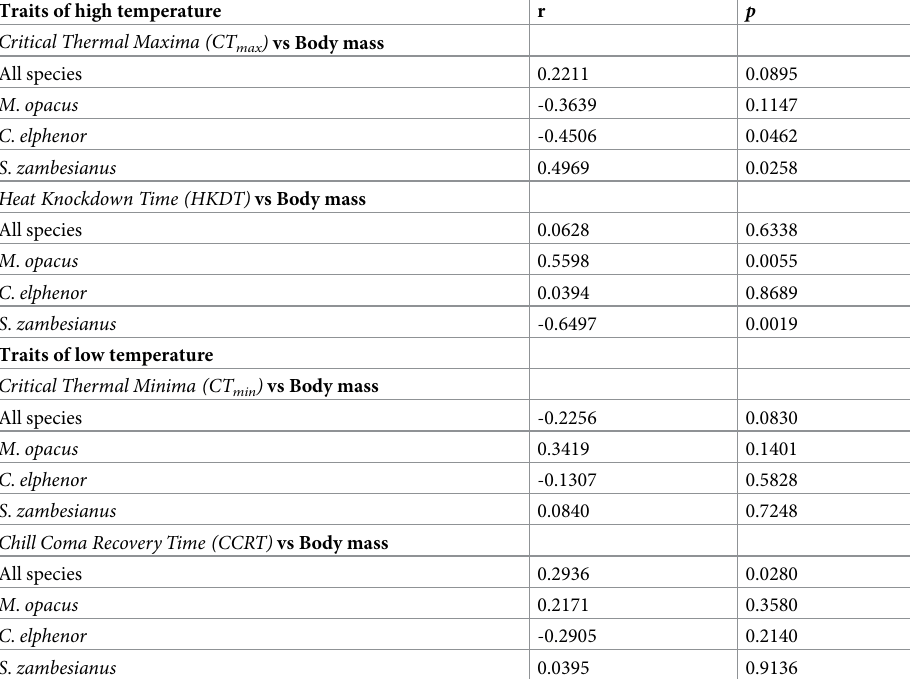
Table 1. The relationship between traits of high and low temperature tolerance and body mass. Analysis was per- formed using linear regression in STATISTICA. Dung beetle species body mass were correlated with traits of tempera- ture tolerance independently and then all species combined. R represents the coefficient of